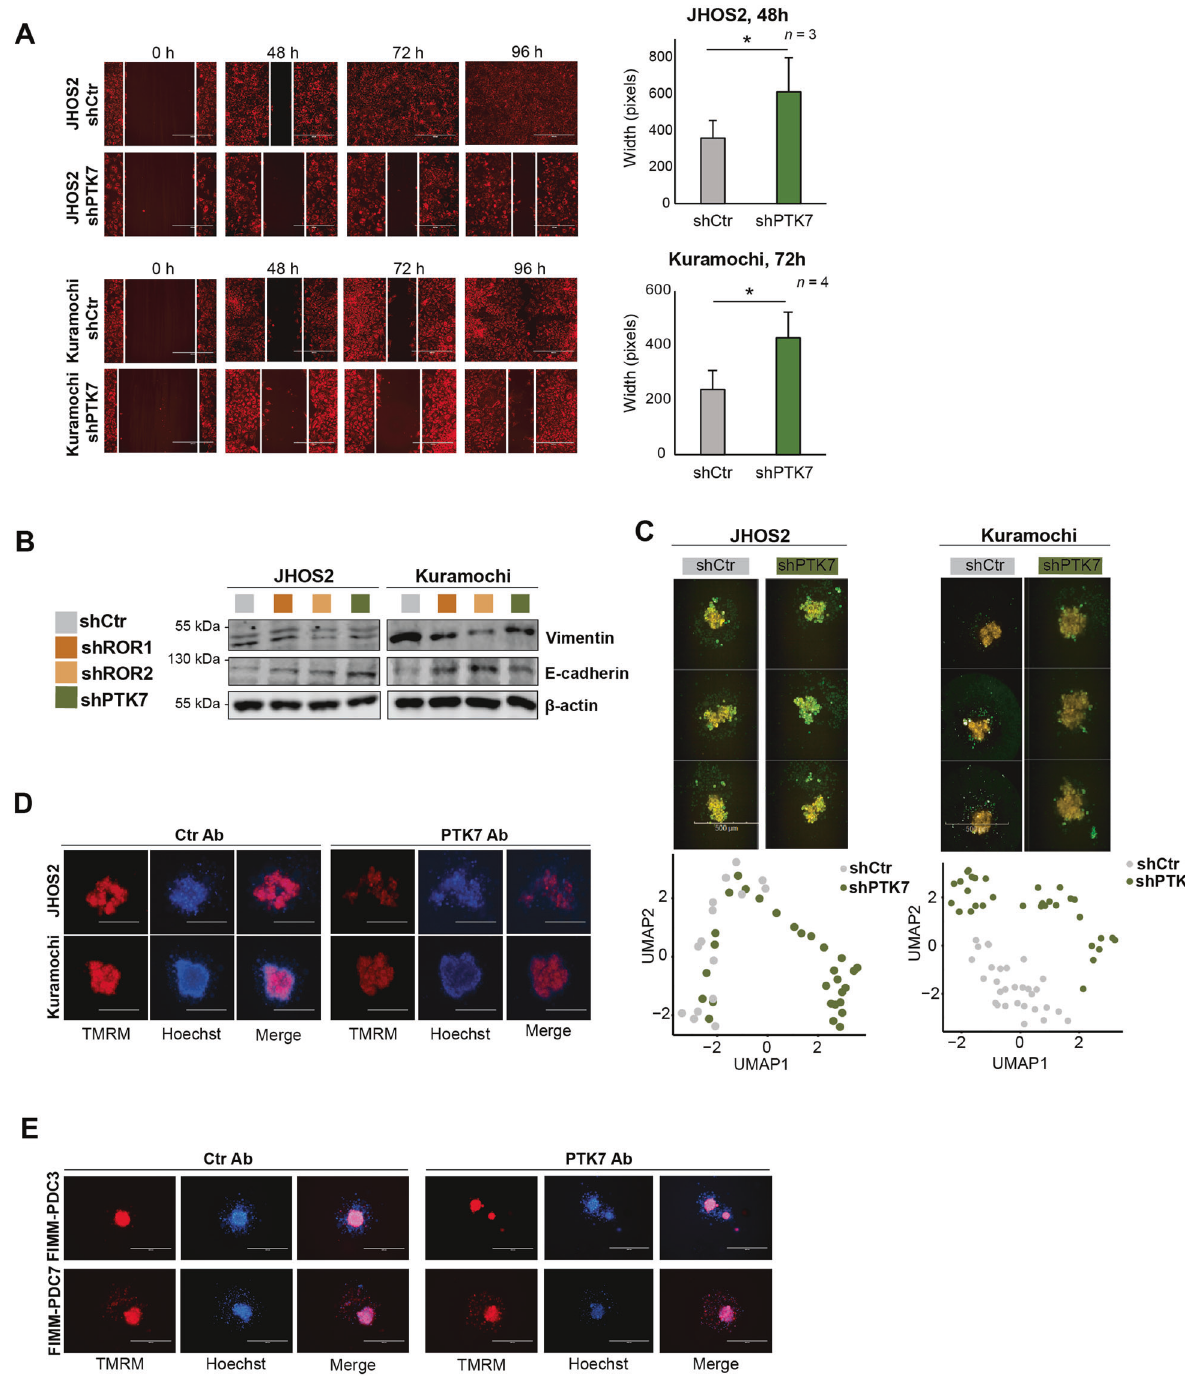
Fig. 5 Targeting PTK7 impairs migration, EMT, and spheroid formation. A Wound-healing assay of JHOS2 and Kuramochi shCtr and shPTK7 cells induced with 100 ng/ml DOX for 6 days prior the addition of TMRE stain. After 24 h, a wound was created, and the healing was observed every 24 h. Scale bar: 400 µm. Right, analysis of the width of the wound was performed with ImageJ and the graphs show mean ( n = images from biological duplicates) ± SD; p- values (two-tailed Student´s t -test): * p ≤ 0.05 B Immunoblot analysis of shRNA JHOS2 and Kuramochi cell lines showing the expression of vimentin and E-cadherin. β -actin was used as loading control. C Representative immuno fl uorescence images of TMRM (yellow) and Dioc6(3) (green) staining (upper panels) and UMAP of high-content image data analysis (lower panels) of JHOS2 and Kuramochi shCtr and shPTK7 spheroids. Scale bar: 500 µm. D , E . Representative immuno fl uorescence images of TMRM (red) and Hoechst (blue, nuclear staining) of OC cell lines ( D ) or PDCs E treated with 20 µg/ml control mAb or PTK7 mAb (cofetuzumab) for 5 days. Scale bar: 500